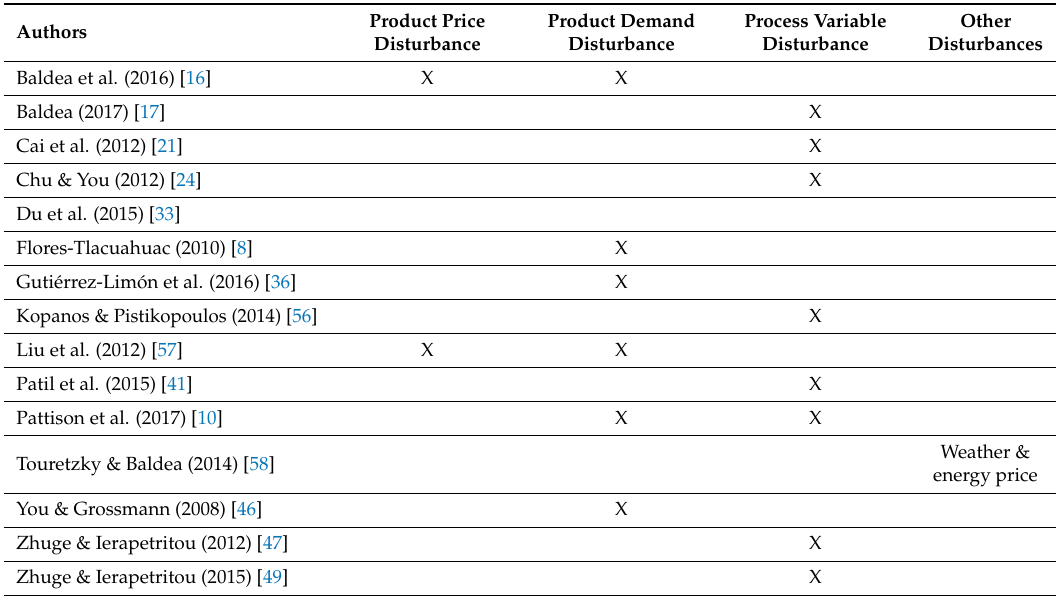
Table 2. Works considering reactive